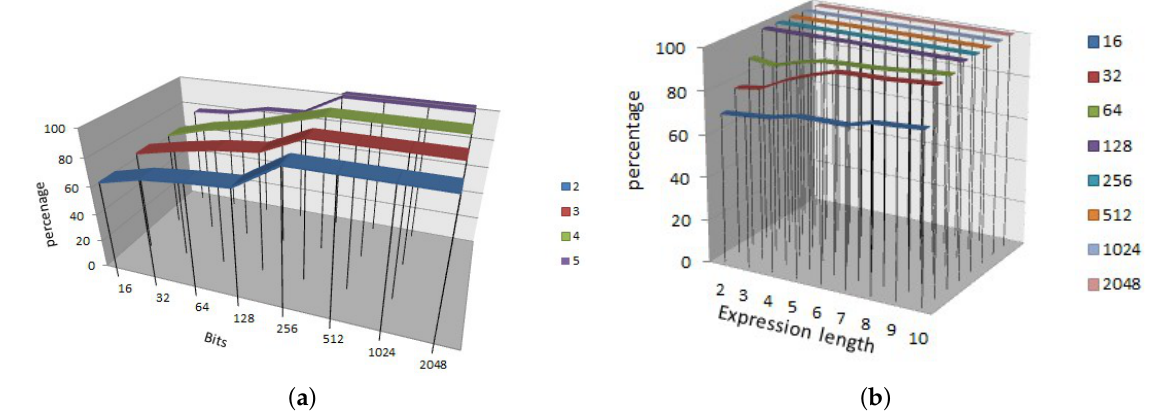
Figure 5. Correlation Immunity. ( a ) Correlation immunity with varying bits and input variables; ( b ) Correlation immunity with varying bits and expression length%.